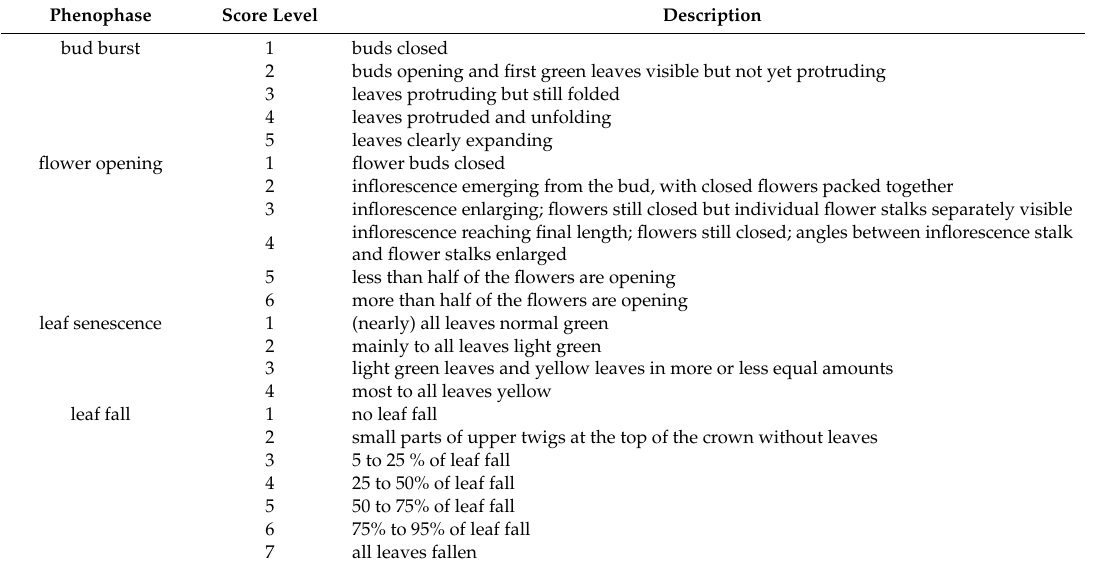
Table 2. Description of the score levels for leaf bud burst, flower opening, leaf senescence and leaf fall.